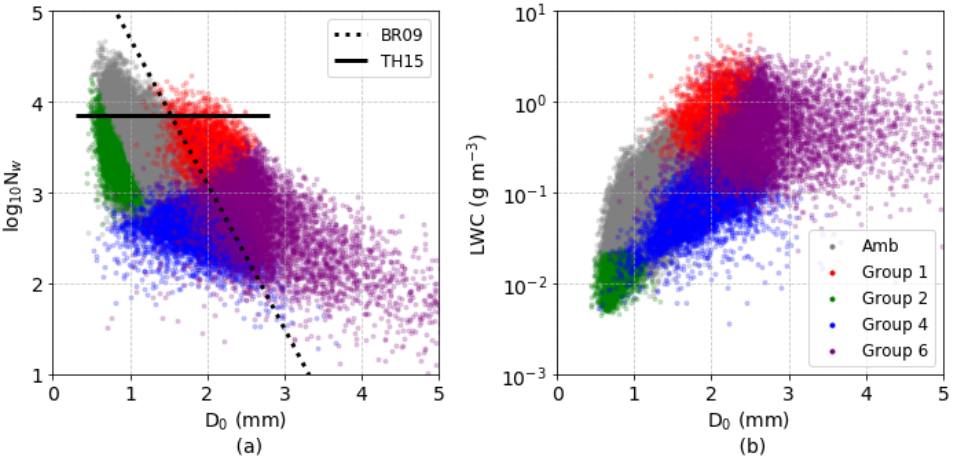
Figure 4. Scatterplots of ( a ) log N w - D 0 and ( b ) LWC- D 0 for the full dataset (Region A + Region B + Region C). The solid and dotted lines in ( a ) indicate TH15 and BR09 convective/stratiform separations, respectively. The colors indicate the groups of the classification proposed by D18. Table 3. Percentage of observations in each group of the classification proposed by D18 for all the data and for each region.